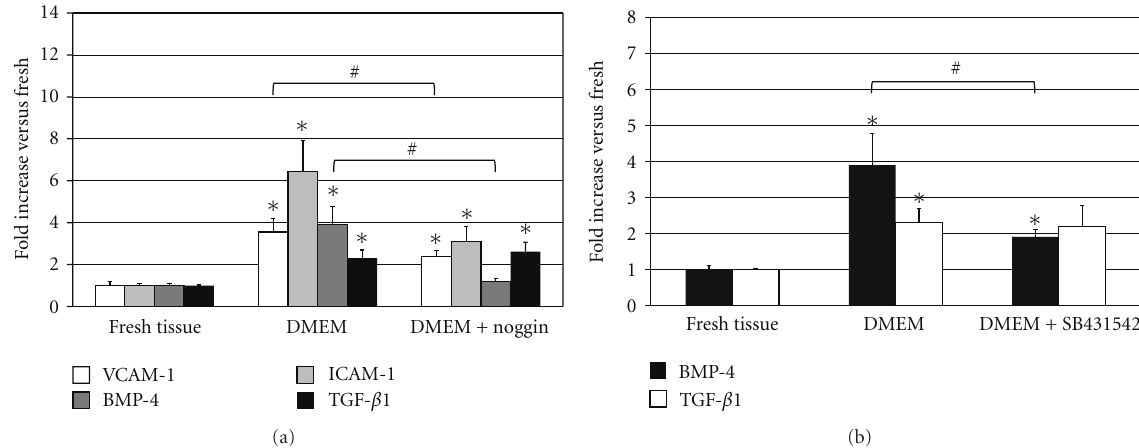
Figure 5: Cytokine and cell-adhesion molecule expressions after exposure of the fibrosa to altered shear stress in culture medium supplemented with (a) noggin and (b) SB-431542 ( ∗ P < . 05 versus fresh; # P < .